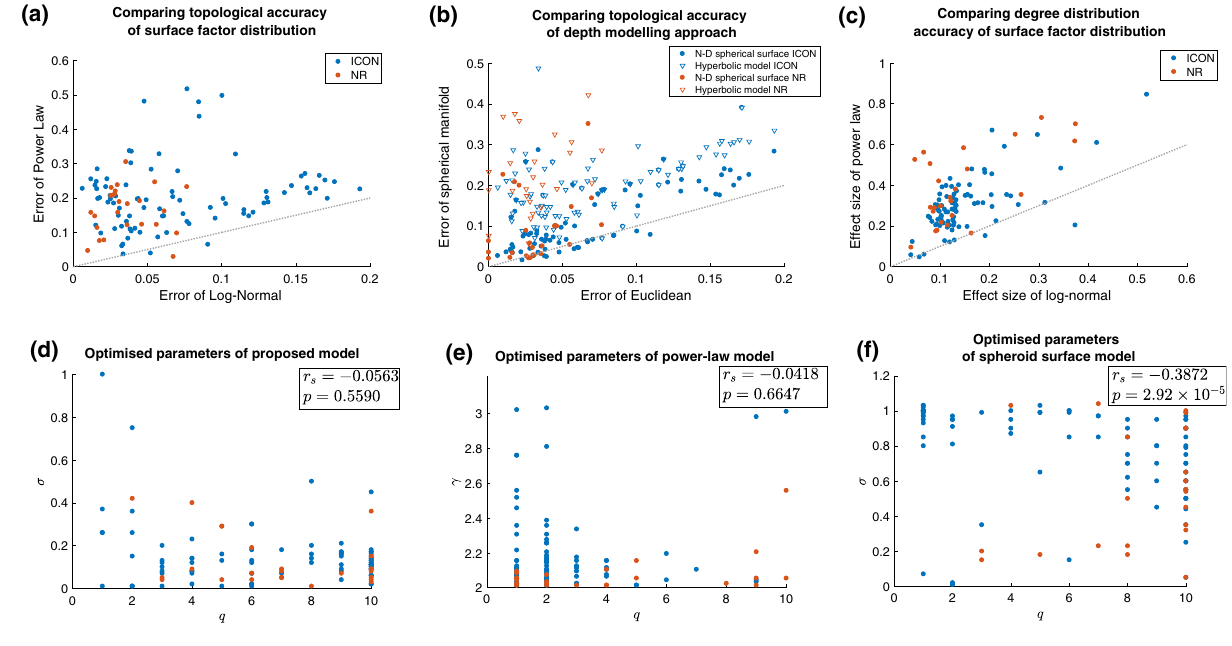
Figure 2. Plots ( a ) and ( b ) show root mean squared errors of the proposed model against power-law attachment spherical surface geometry (including the hyperbolic model), respectively. ( c ) Effect sizes of degree distributions between model and network (log-normal versus power-law attachment). Dotted lines show the line of parity while ICON is dataset from the Index of Complex Networks and NR is the dataset from the network repository. Plots ( d – f ) show the surface model parameter plotted against the depth model parameter for the proposed theory, power-law attachment theory and spherical surface geometry theory, respectively. Spearman’s correlation coefficients, r s , and their p -values between the parameters indicate how correlated the model parameters are across the 110